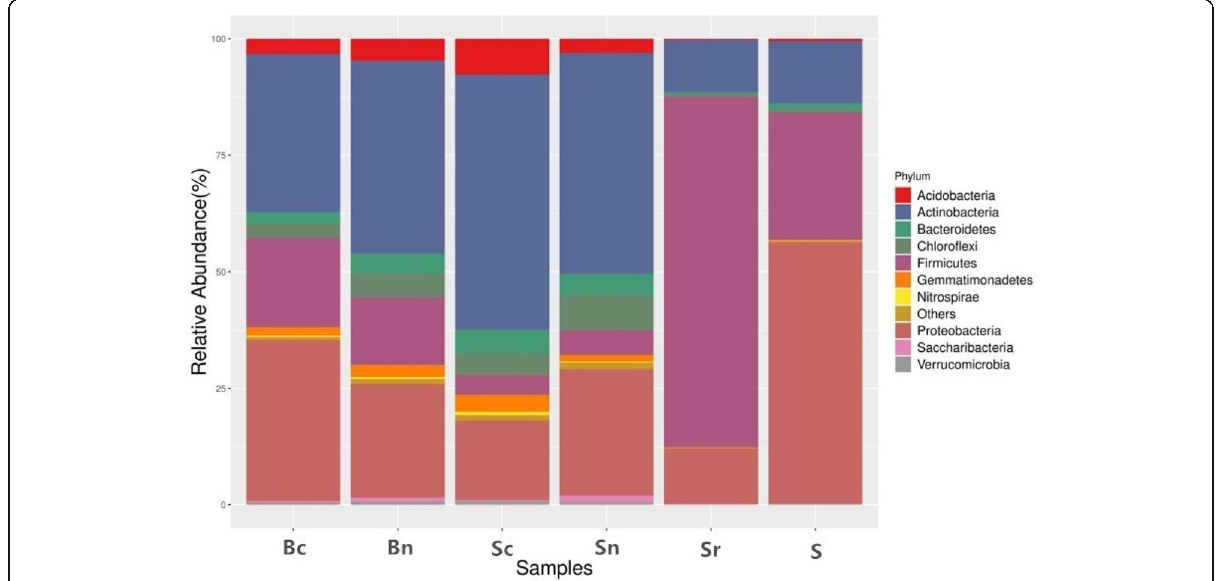
Fig. 4 Relative abundance at phylum level in each sample. Three internal averages of each group were taken to get six columns of OTU tables. Combine the phylum-genera annotations in which each OTU represented the sequence, and the above table. The absolute value of each species at the phylum-genera level was obtained, converted to a percentage, and then plotted. The figure showed the top 10 phyla with the highest total content, while the rest were merged into